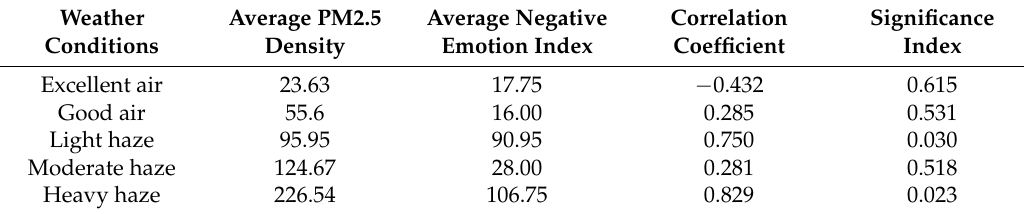
Table 6. Statistics and correlation analysis results of the sample data at different haze levels in January and November.